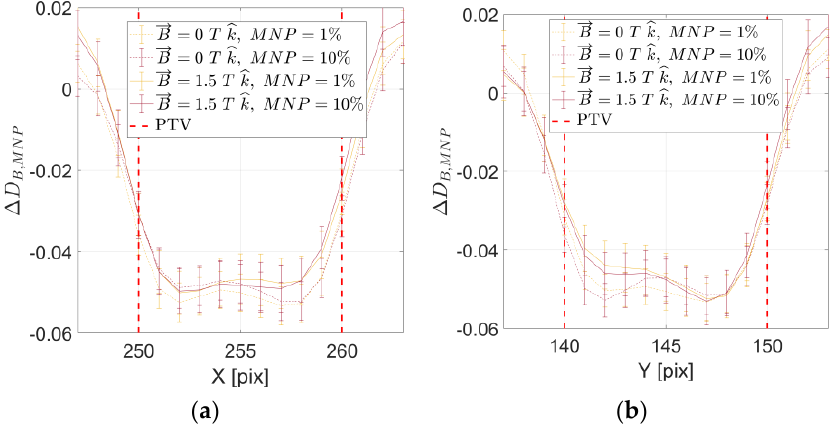
Figure 6. Dose distribution vertical ( a ) and horizontal ( b ) profiles for the transversal plane reporting all configurations, varying MNP concentration and magnetic field (parallel to incident X-ray beam) presence. Vertical red dashed lines delimit the FeNP-infused target (PTV). Reported uncertainties correspond to 1 standard